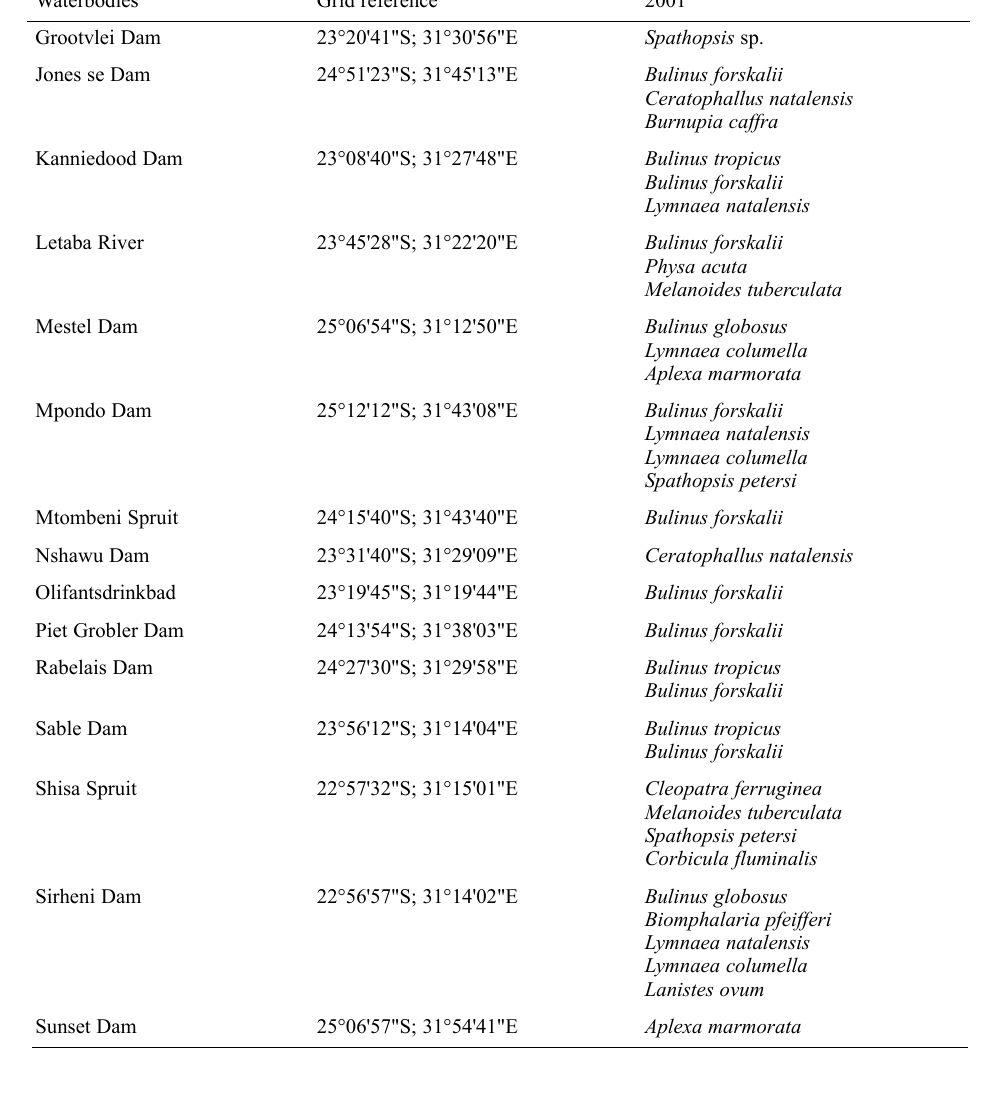
Table 2 Molluscs found in waterbodies of the Kruger National Park surveyed for the first time in 200 1